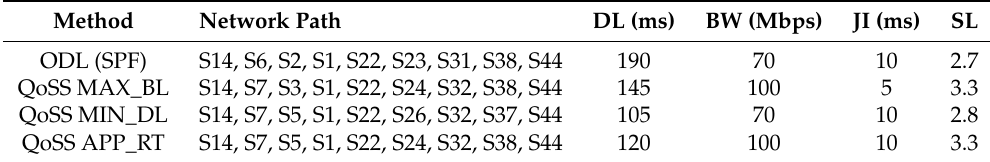
Table 9. ODL default and QoSS optimal paths metrics from Hosts 1 to 14 in the simulation model.